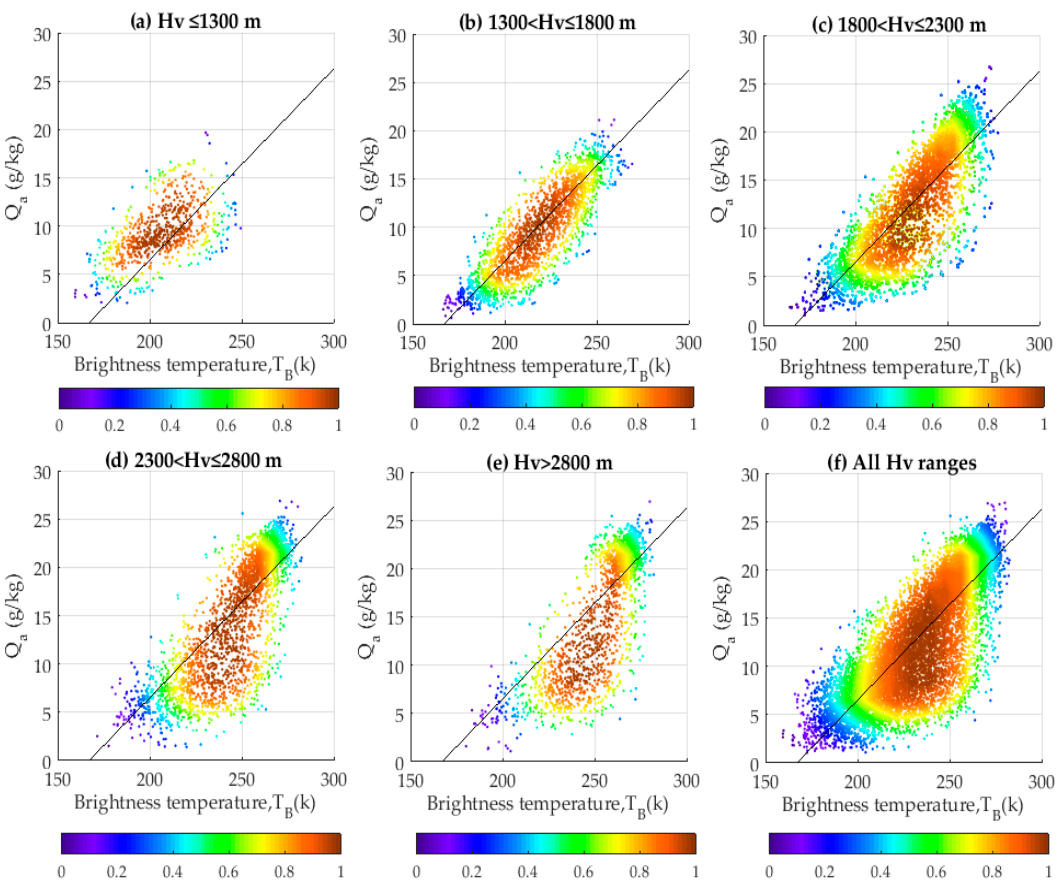
Figure 4. Scatter diagrams showing the relationship between T B ,89 H , Q a , and H v , using the Sample 1 data. ( a ) For H v ≤ 1300 m; ( b ) for 1300 m < H v ≤ 1800 m; ( c ) for 1800 m < H v ≤ 2300 m; ( d ) for 2300 m < H v ≤ 2800 m; ( e ) for H v > 2800 m; and ( f ) for all H v ranges. Each figure shows a linear regression line calculated using all H v range data. Color depth indicates the density of data.